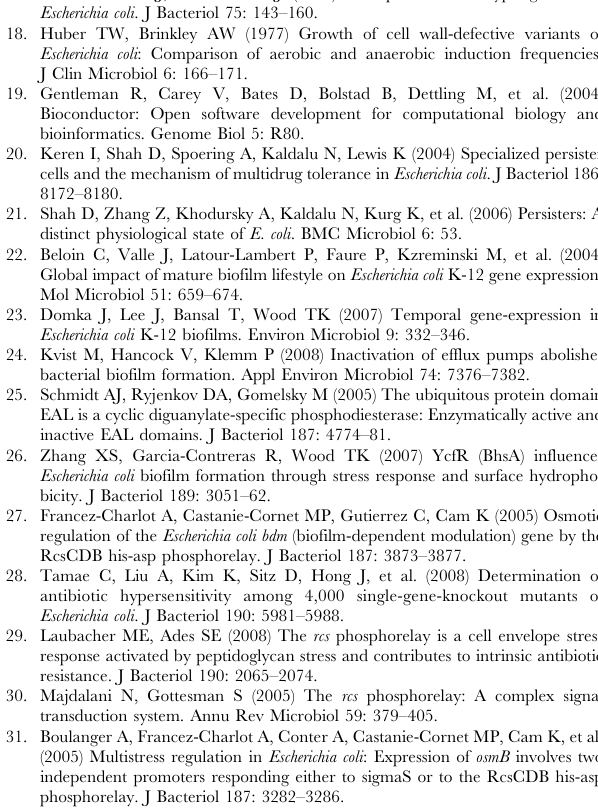
Table S3 Correlation of microarray data with real-time PCR